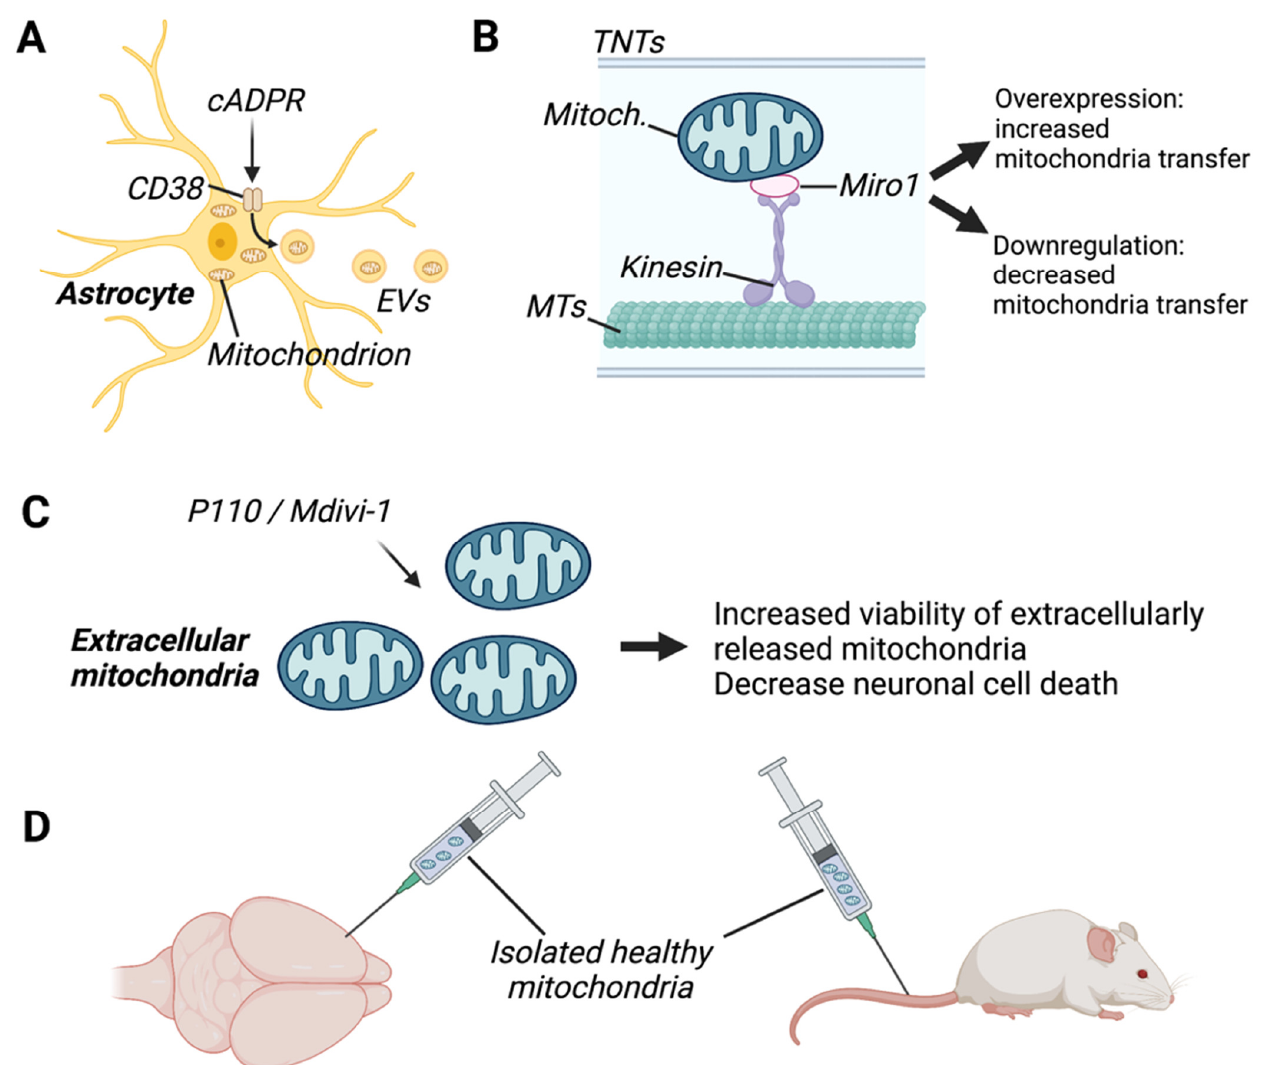
Figure 3. Examples of therapeutic approaches targeting mitochondrial transfer in the brain. ( A ) En- hancement of mitochondrial transfer via extracellular vesicles (EVs) was performed by activating astrocytic CD38 (cluster of differentiation 38) with cyclic ADP-ribose (cADPR), which improved neuronal viability in a model of stroke. ( B ) Enhancement of mitochondrial transfer via tunnelling nanotubes (TNTs) was done by overexpressing the mitochondrial Rho-GTPase 1 (Miro1), which increased TNT formation. ( C ) Inhibition of mitochondrial fusion proteins and dynamin-related protein 1/fusion 1 (DRP1/FIS1), with P110 or Mdivi1, was shown to improve the viability of extracellular mitochondria, decreasing neuronal death. ( D ) Therapeutic approaches consisting of intracranial or intravenous injection of healthy mitochondria in rodents revealed that transplanted mitochondria are present in brain resident cells and exerted protective effects. MTs, microtubules. Created with BioRender.com (accessed on 7 November 2022).